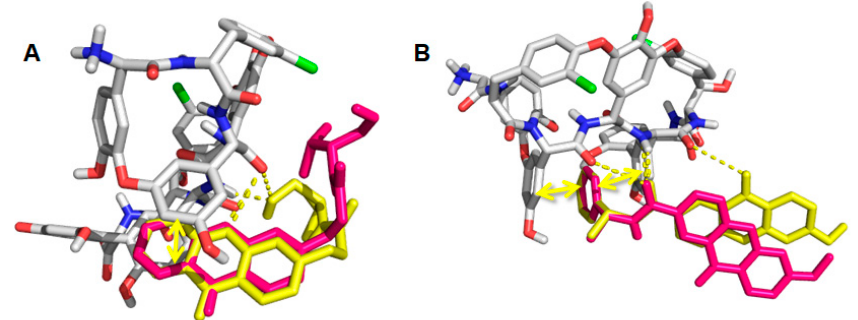
Figure 10. ( A ) Analyte 2 docked on teicoplanin aglycone selector; ( B ) Analyte 17 docked on teicoplanin aglycone selector. Chiral selectors are represented in sticks with C, O, N, and Cl atoms colored in grey, red, blue, and green, respectively. ( S ) and ( R ) enantiomers are represented with magenta and yellow sticks, respectively. Hydrogen interactions and π -stacking interactions are represented with dashes and double arrow, respectively.